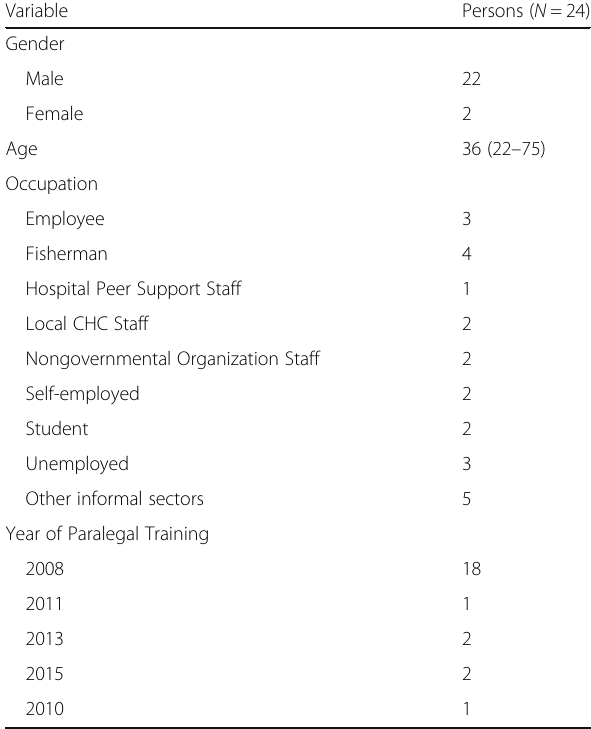
Table 1 Characteristics of the study population